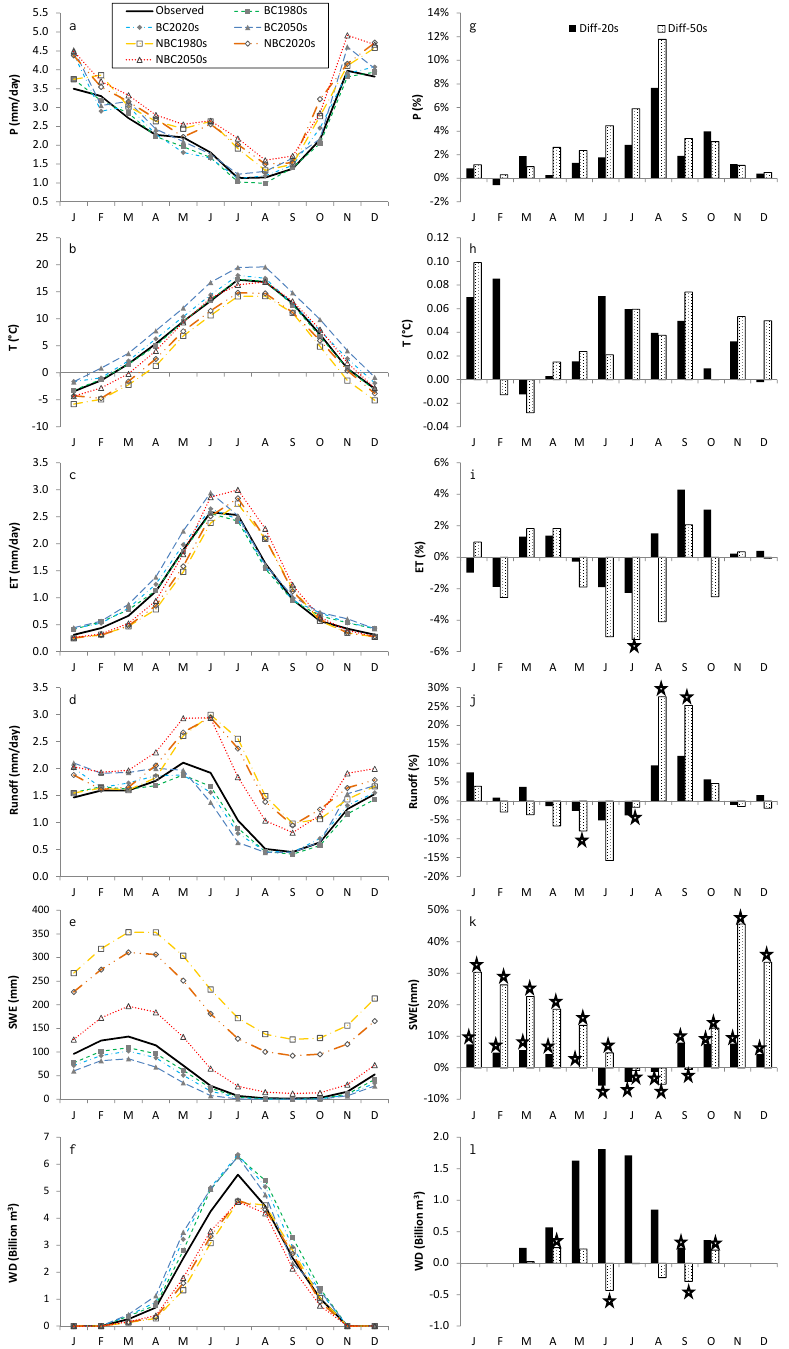
Fig. 6. Seasonal patterns of differences in climate and simulated hydrological variables driven by bias-corrected (BC) and non-bias- corrected (NBC) data. The left column is monthly mean (from January to December) over different scenarios and time periods; the right column is the differences between BC- and NBC climate and modeled variables in two periods, i.e., 2020s–1980s and 2050s– 1980s. The unit of water demand (WD) is billionm 3 . Note: plotted for precipitation, ET, runoff, and SWE are differences in per- centage changes, i.e., ( 1 BC 20 s − 80 s /BC 1980 s × 100% ) − (1 NBC 20 s − 80 s /NBC 1980 s × 100%) for changes between 1980s and 2020s and ( 1 BC 50 s − 80 s /BC 1980 s × 100% ) − (1 NBC 50 s − 80 s /NBC 1980 s × 100%) for changes between the 1980s and 2050s; plotted for temperature and water demand are differences in absolute changes, i.e., 1 BC 20 s − 80 s − 1 NBC 20 s − 80 s for changes between the 1980s and 2020s and 1 BC 50 s − 80 s − 1 NBC 50 s − 80 s for changes between the 1980s and 2050s. The small stars under or above each column mean p value < 0.05 for the Student t test of differences between BC anomalies and NBC anomalies for each